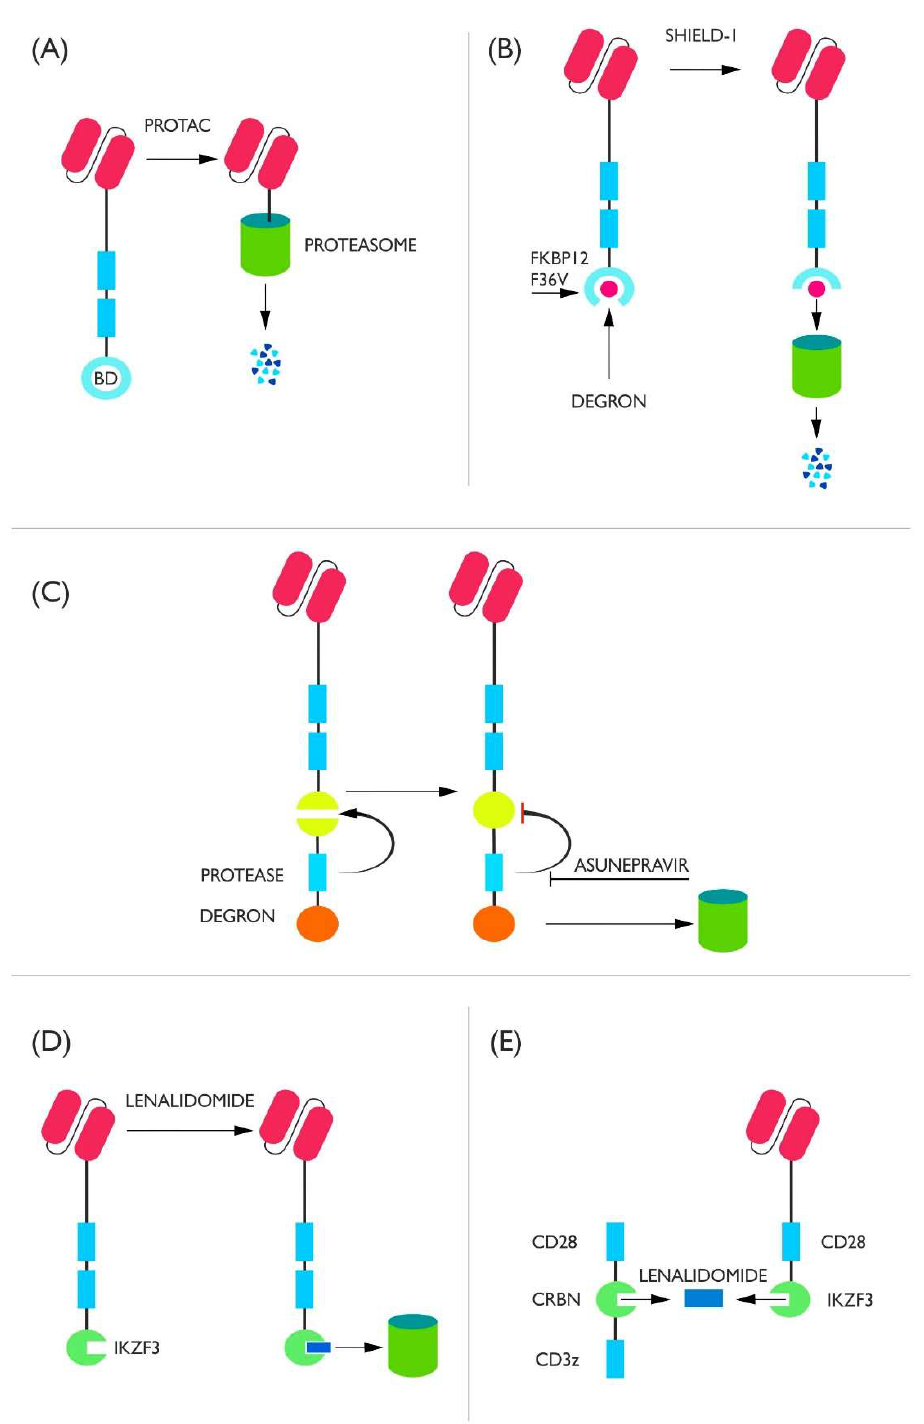
Figure 2. ( A ) The CAR protein is bound to the bromodomain. Upon delivery of the PROTAC compound, CAR attaches to the proteasome and is degraded. ( B ) The CAR protein is connected to a degron spatially covered by the FKBP12 F36V protein. Under the influence of the Shield-1, FKBP12 changes its conformation, exposing the degron, which leads to proteolysis. ( C ) CAR is linked to protease and a degron. Protease spontaneously cuts off the degron from the CAR protein so that it is not degraded. When asunepravir is administered, the protease is blocked and the whole CAR is destroyed in the proteasome. ( D ) Off switch. Addition of lenalidomine leads to proteasomal degradation. ( E ) On switch. Administration of lenalidomide causes two separate parts of the receptor to fuse into a whole and activates the